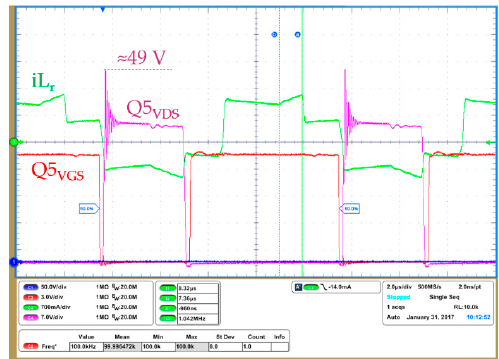
Figure 26. Detail on the SRs overshoot and the primary side current with the clamping diodes on the leading leg position.